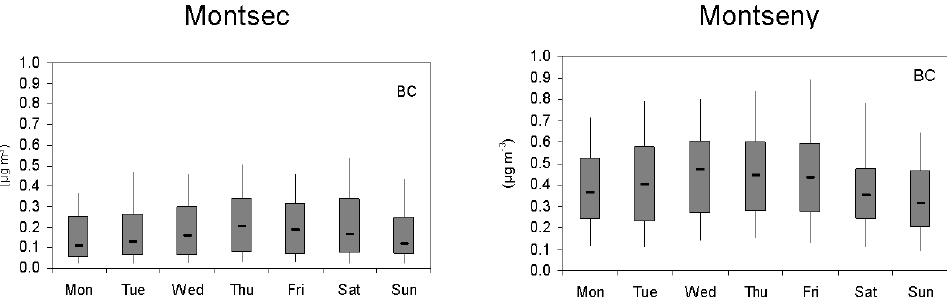
Fig. 11. Daily median (black line within the boxes) and percentiles (5-25-75-95, boxes and whiskers) of BC concentration during the study period at Montsec and